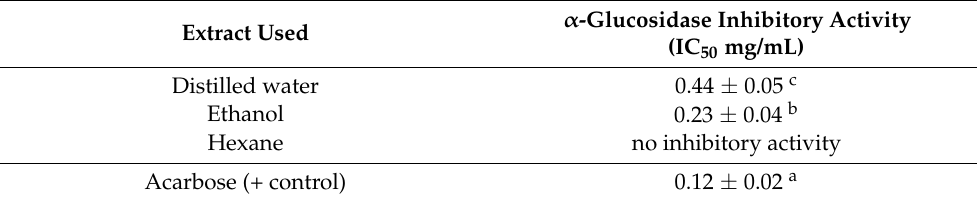
Table 3. In vitro α -glucosidase inhibitory activity of C. nervosum extracts. Extract